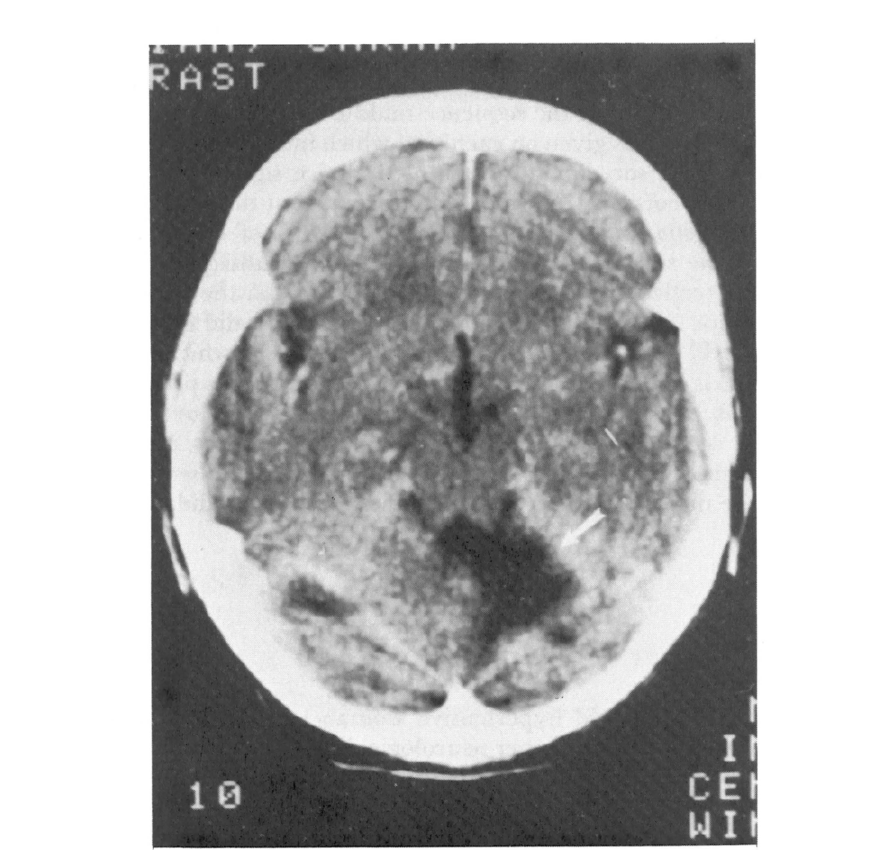
FIG. I. CT scan of patient CG. Note the infarcted medial cerebellar